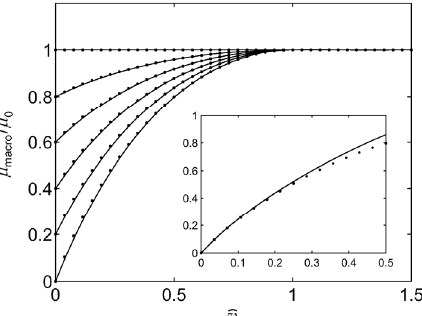
Fig. 3 Dependence of the normalized coefficient of friction on the normalized velocity for / 0, 0.2, 0.4, 0.6, 0.8, 1.0 u u   ,0 z z (from top to bottom). Points represent the results of numerical evaluation of the Integral (9). Solid lines represent the empirical Approximation (11). The inset shows the low-velocity asymptotic Solution (12) (solid line) compared to the numerical Solution (9) (points).